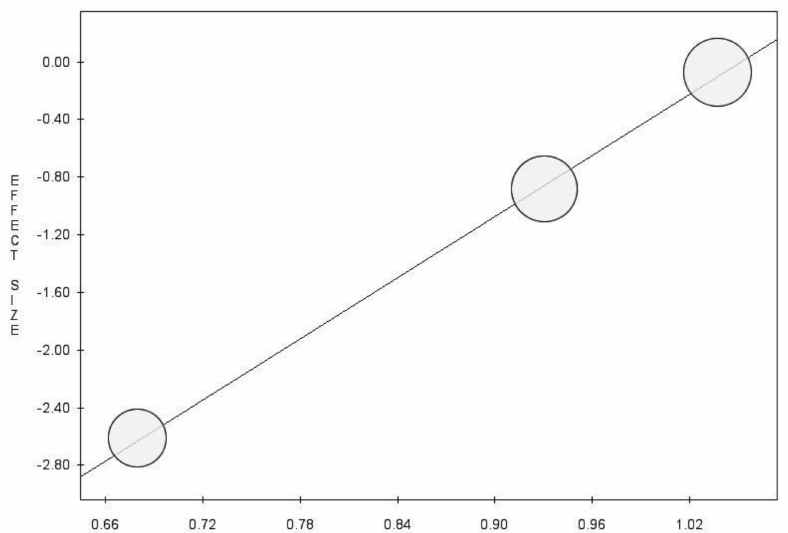
Figure 4. Metaregression of the proportion of patients with T1 BCa among those treated with 5- ARIs / proportion of patients with T1 BCa among those not treated with 5-ARIs and the RR of BCa recurrence on the RR of BCa recurrence (y= − 7.44 + 7.07 x, p = 0.014).